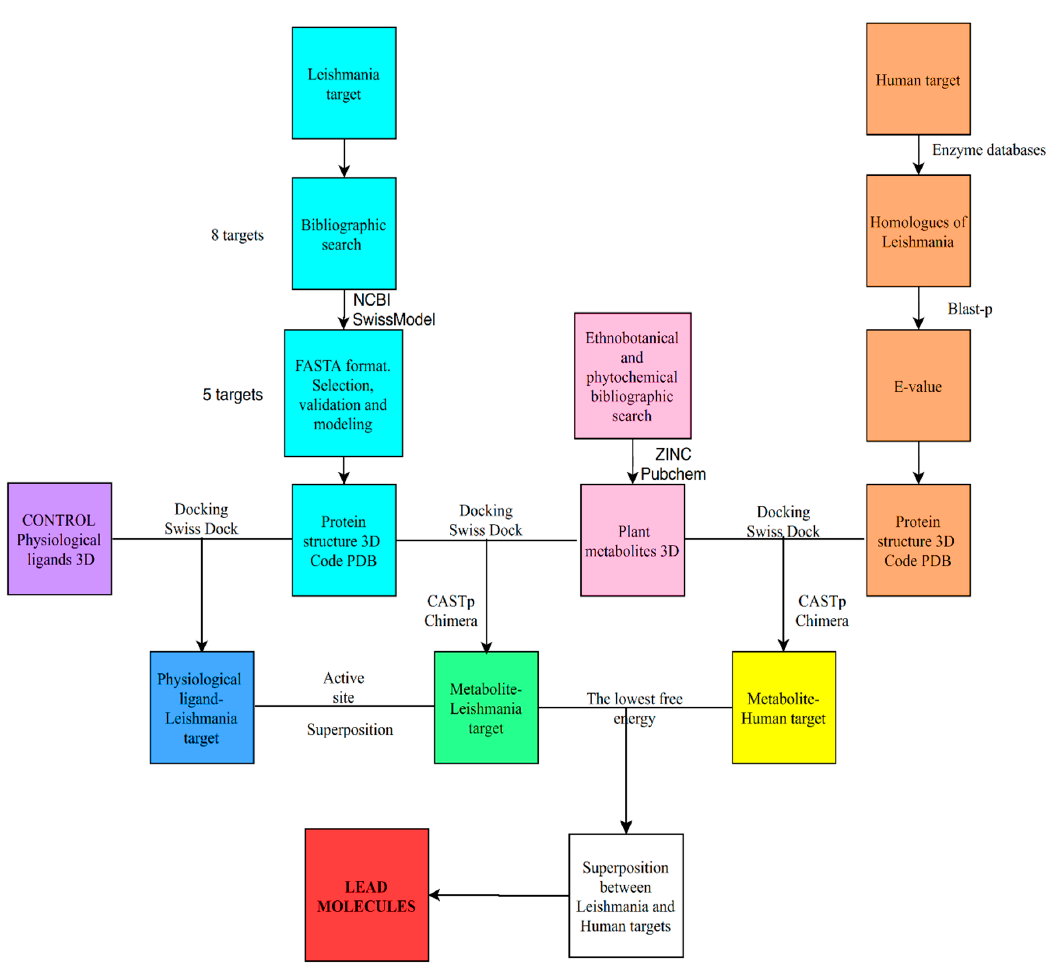
Figure 5. Flow chart of the in silico methodology followed in this work.